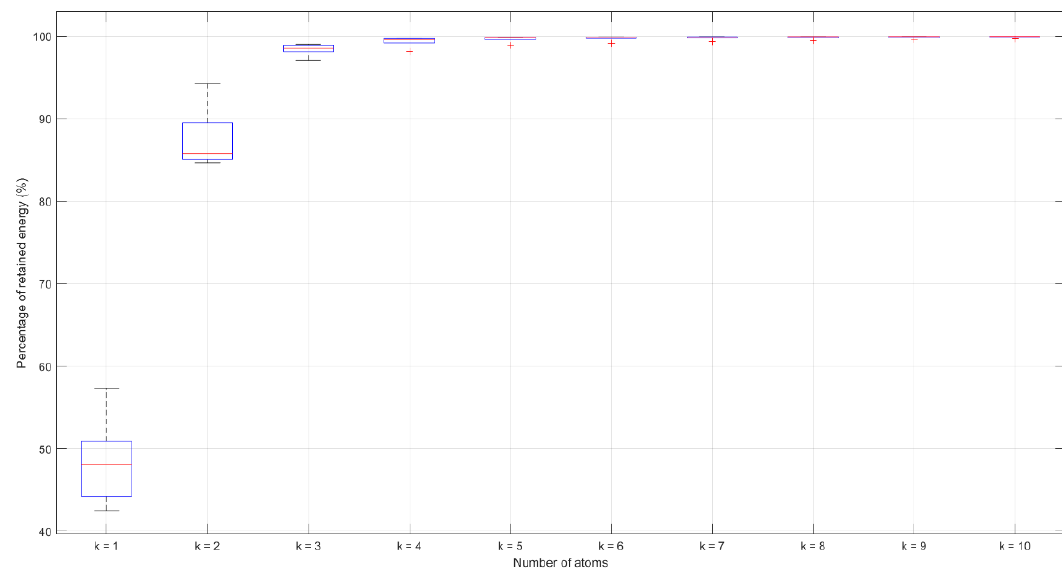
Figure 2. Percentage of retained energy, RTE.